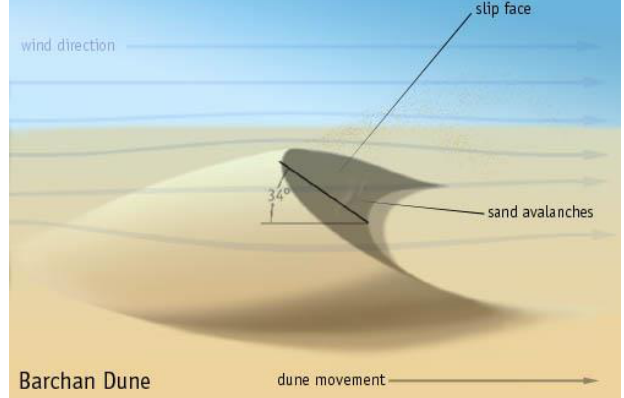
Figure 2. Barchan dune diagram, illustrating wind, dune movement, and slip face [37] (licensed CC BY-SA 3.0).